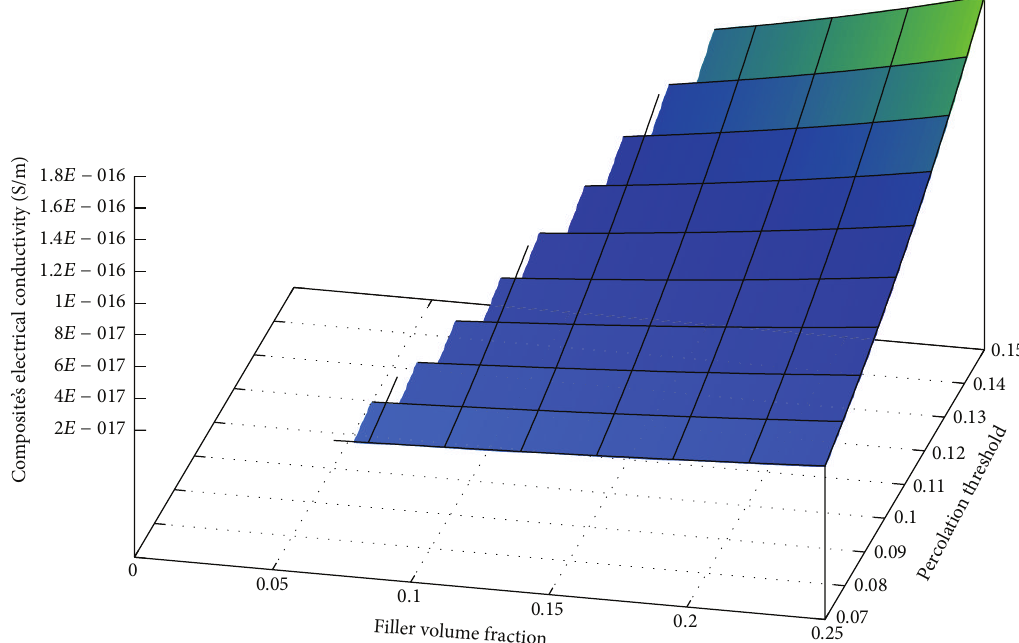
Figure 15: DC electrical conductivity of the nanocomposite at varying both the percolation threshold of the filler and the volume fraction of the filler (McLachlan’s model).